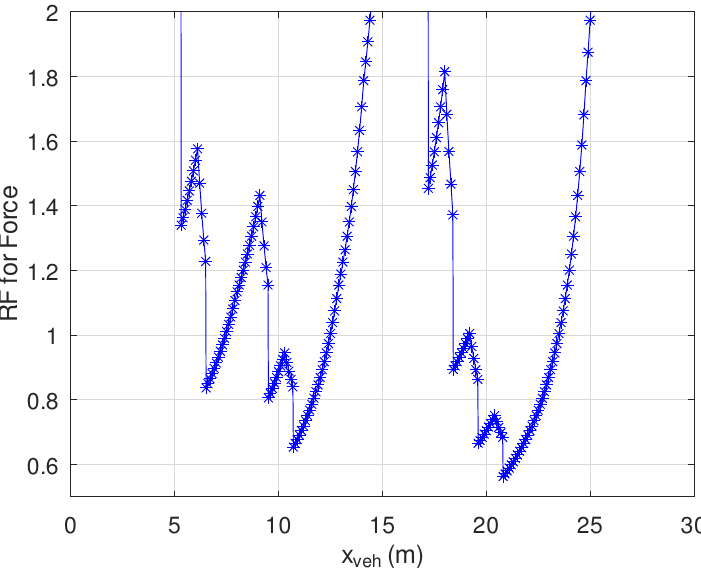
Figure 12. Rating Factor for force versus x veh for the simply-supported beam.